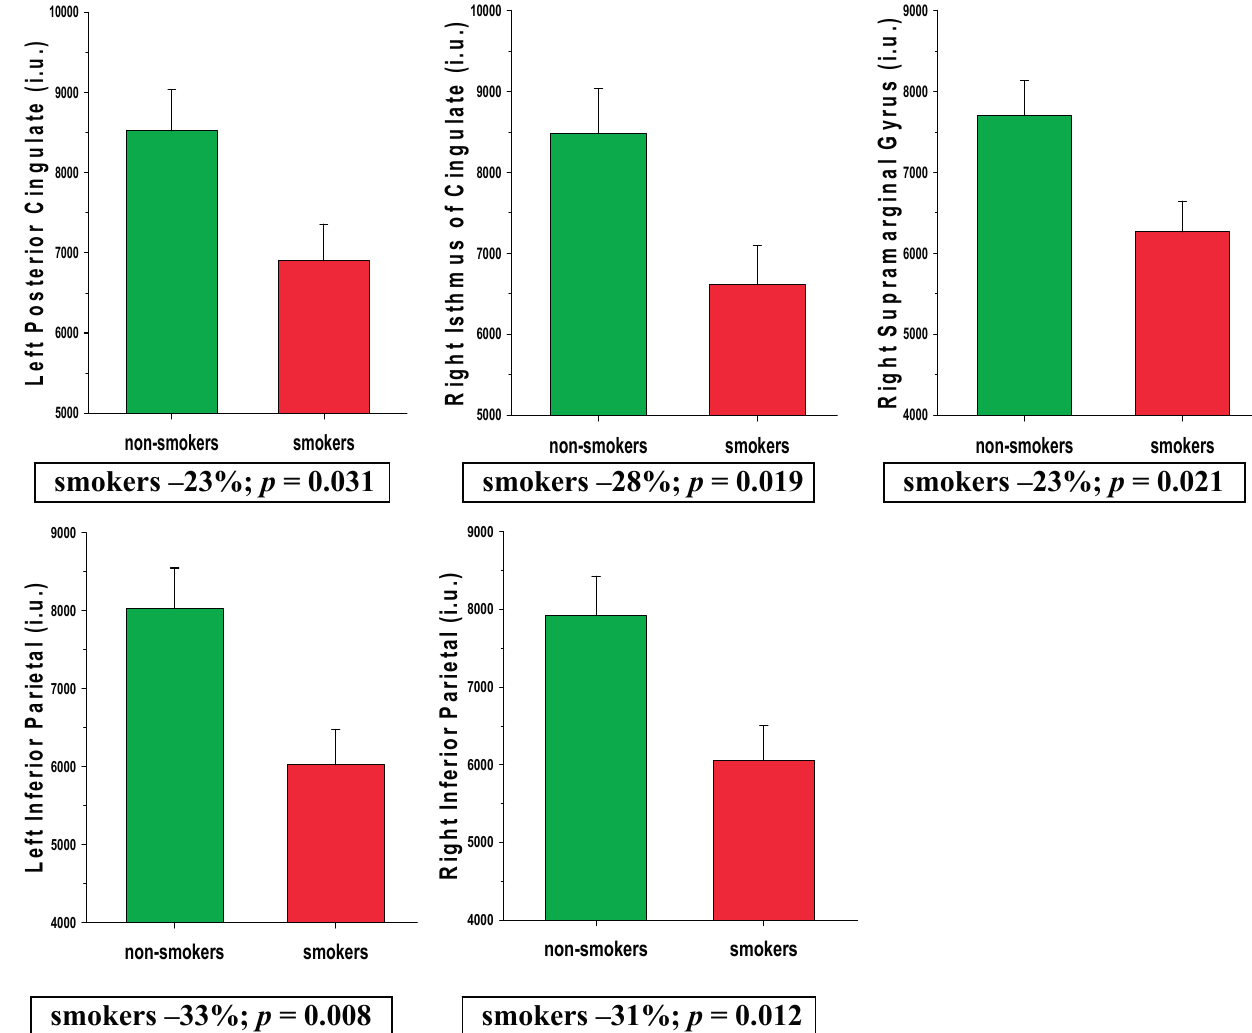
Figure 2. Comparisons of smokers and non-smokers on AD region perfusion